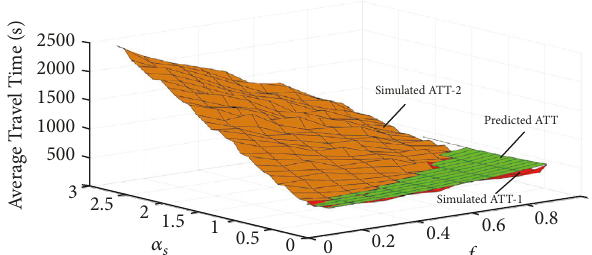
Figure 5: Predicted and simulated results of passengers average travel